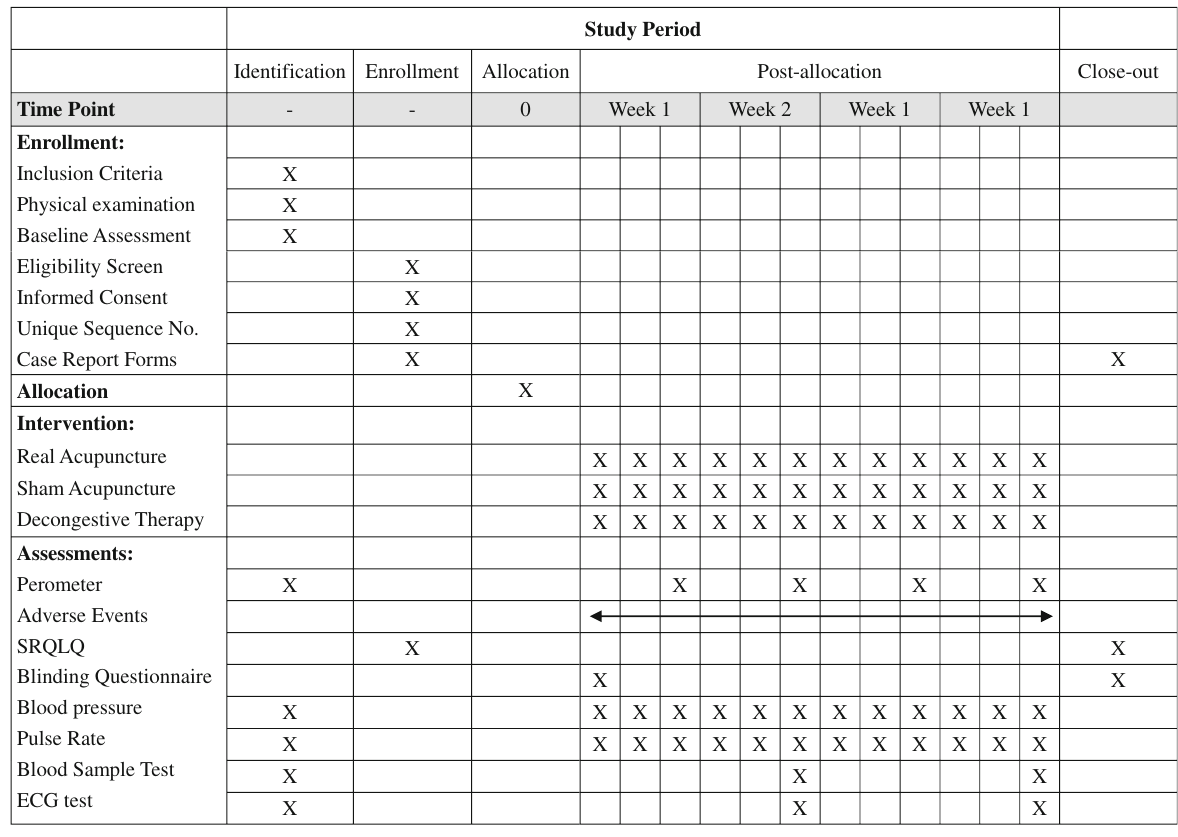
Table 1 Procedures and time-points of enrollment, intervention, and assessment in this trial